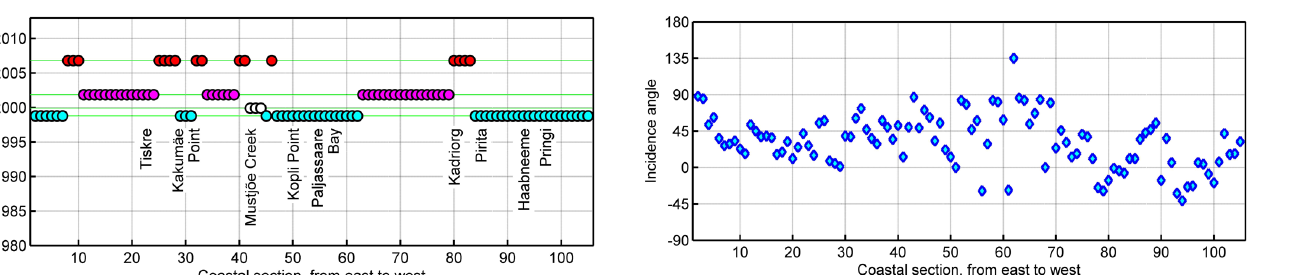
Fig. 5. Four storms (marked with different colours) that caused the highest waves in the study area in 1981–2012.